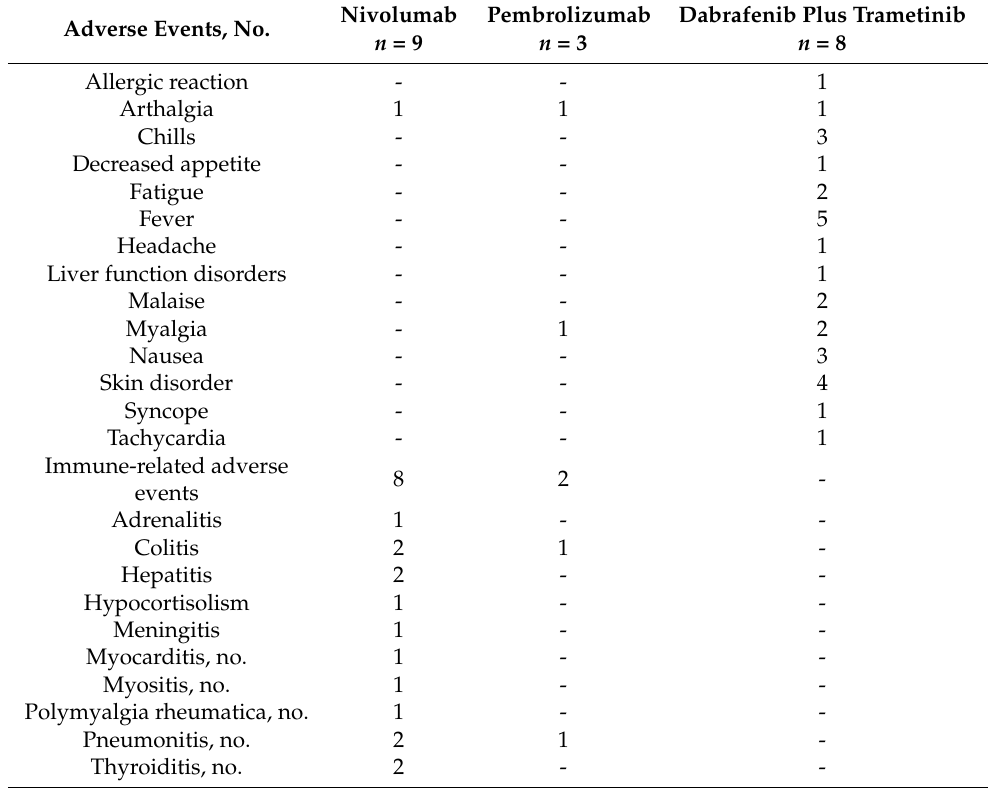
Table 4. Treatment-limiting adverse events in patients who ended treatment due to toxicity.